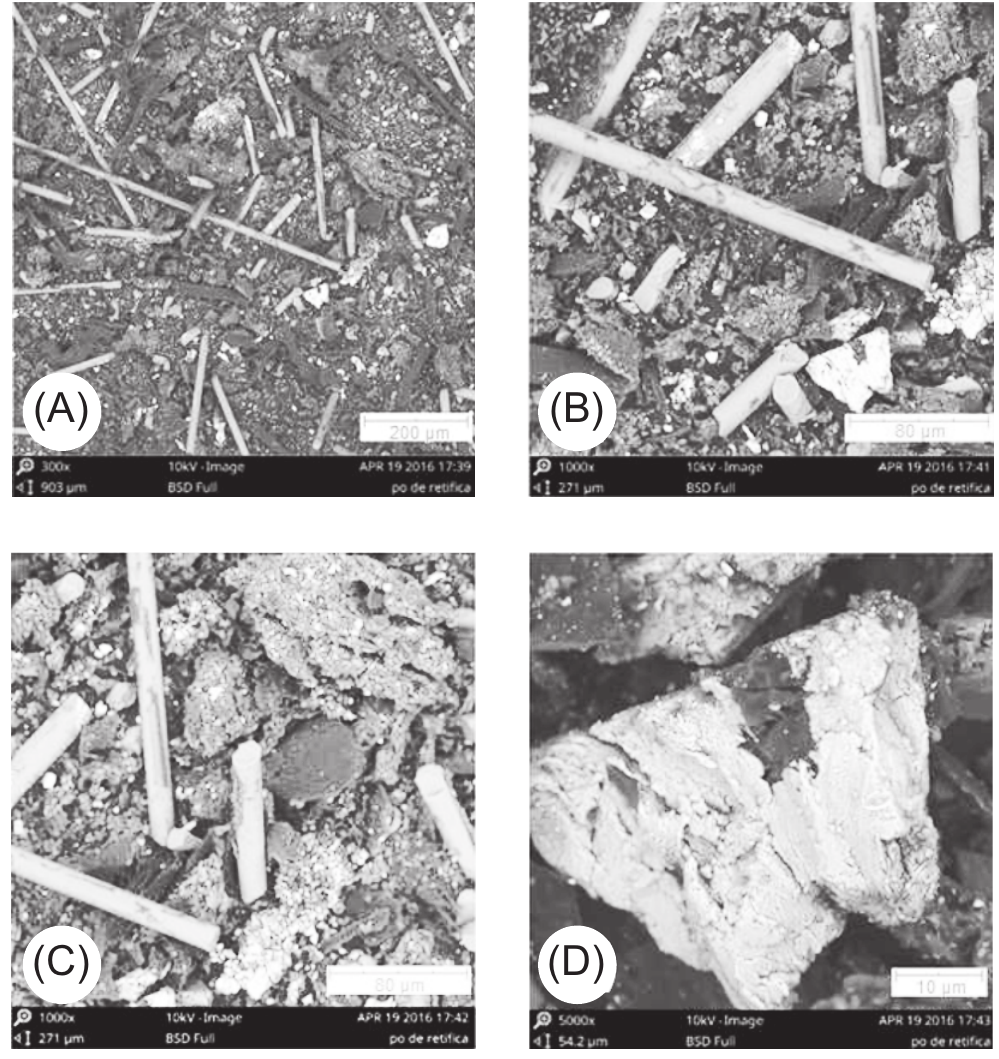
Micrographs of GD obtained by scanning electron microscopy (SEM), showing: (A) general view of the morphology of the particles present in the GD; (B) approximation of the particle overview; (C) stick-shaped particle; (D) irregular shaped